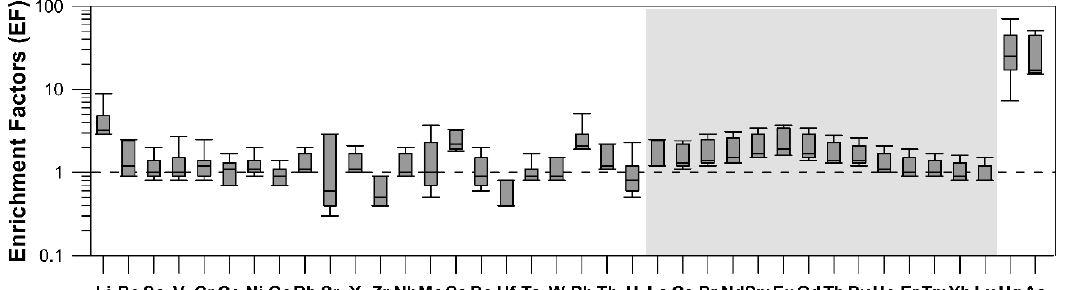
Figure 11. Box and whisker plots for the enrichment factors (EF) for each trace element and Rare Earth Element (REE) (highlighted by gray shadow). The box includes data distributed between the first and third quartile, while the horizontal bar in the box refers to the median value. The ends of the whiskers are the maximum and minimum values. Soil and sediment samples are examined together for the low number of data. The total number of data points used to build each box plot is 7. The Y -axis is logarithmic (Log base 10).